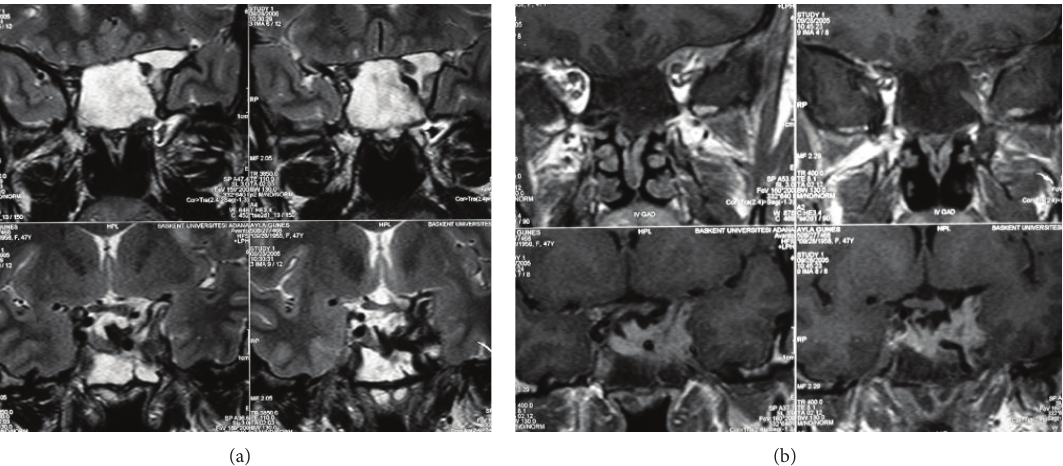
Figure 2: Follow-up magnetic resonance imaging, (a) coronal T2-weighted turbo spin echo image shows cyst formation within the macro- adenoma with a small solid portion on the left lateral side. (b) Postcontrast coronal spin echo image revealed resolution of the macroadenoma in the suprasellar